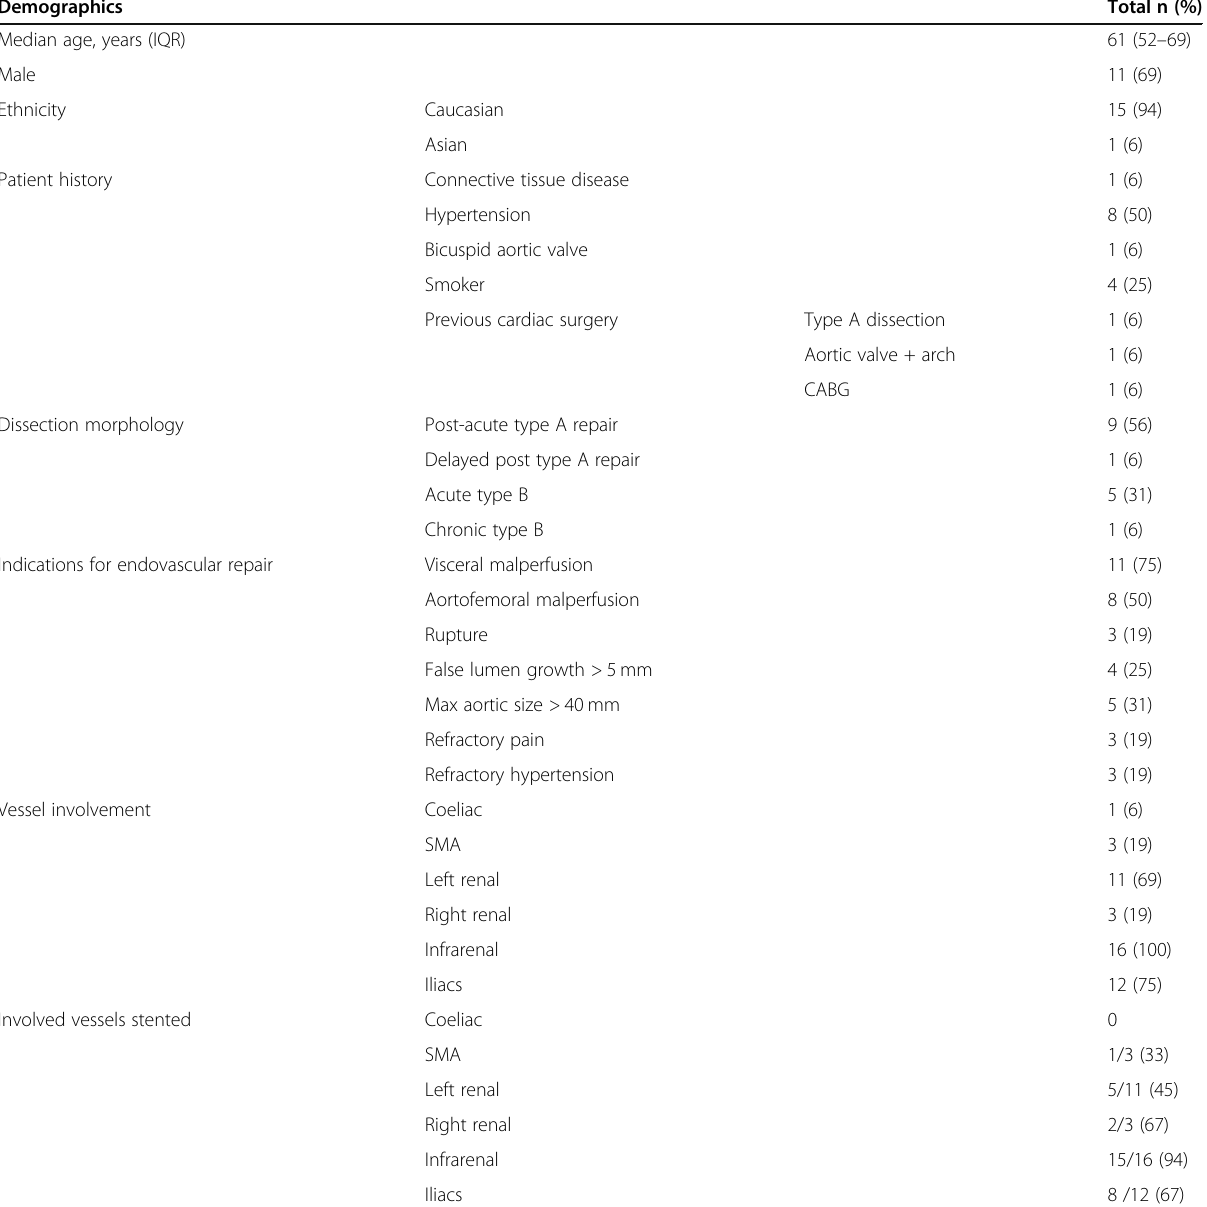
Table 2 Demographics of patients who underwent STABILISE intervention